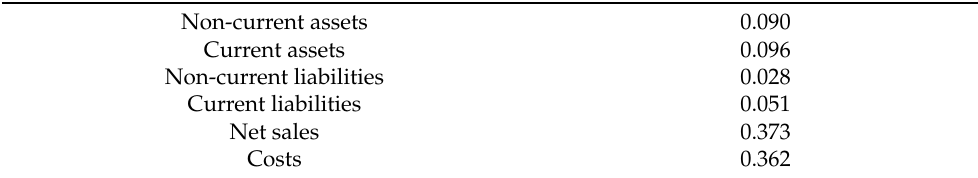
Table 1. Closed arithmetic part means acting as weights.